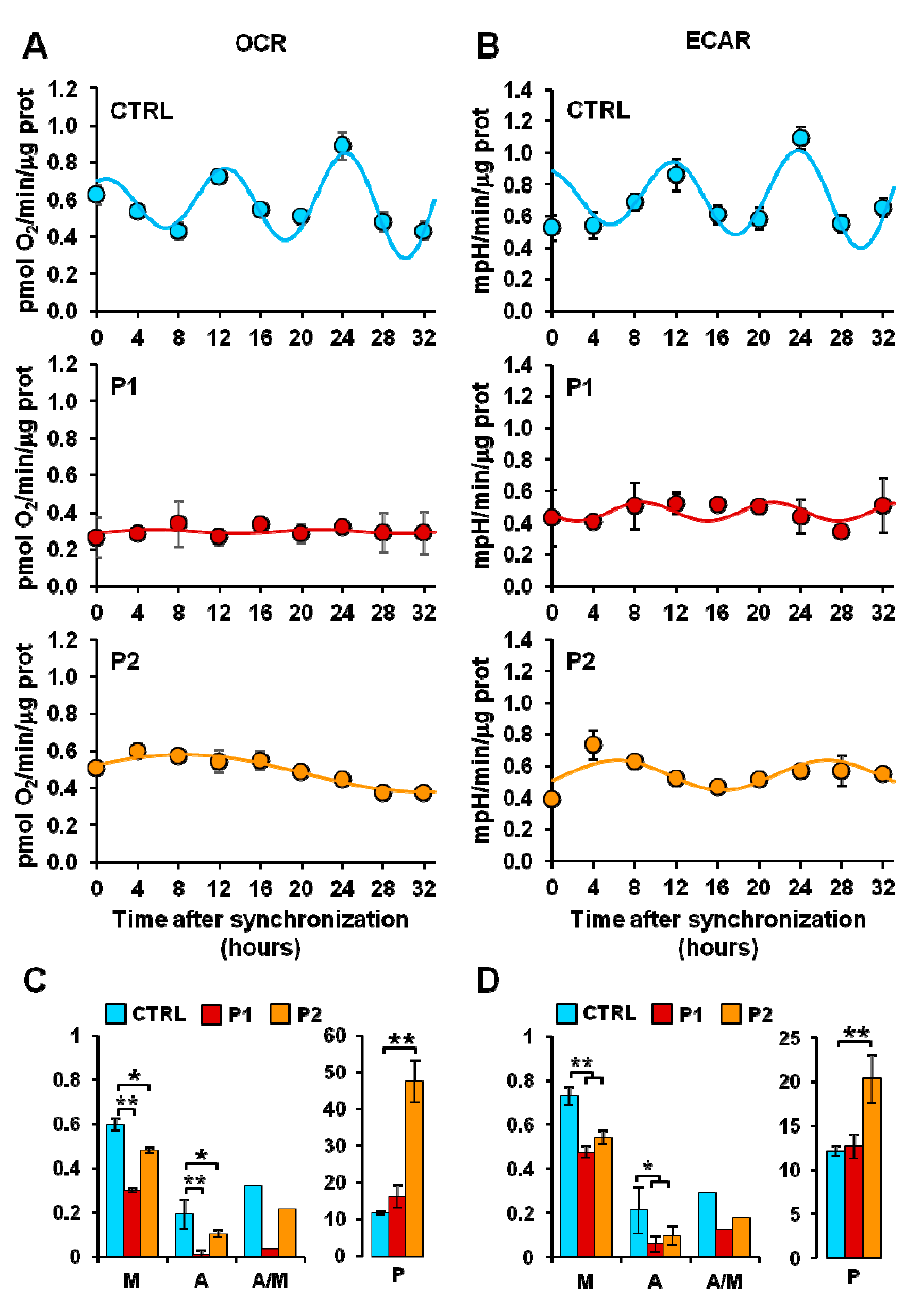
Figure 4. Measurement of the mitochondrial respiratory and glycolytic activity in serum shock-synchronized intact fibroblasts. ( A ) Resting oxygen consumption rate (OCR) and ( B ) basal extracellular acidification rate (ECAR) in serum shock-synchronized normal fibroblasts (CTRL) and PD patient-derived fibroblasts (P1, P2)—the time-course data points were best fitted with the COSINOR function. ( C , D ) The histograms display the mesor (M), the amplitude (A), and the A/M ratio for respiration ( C ) and glycolysis ( D ) of the best-fitting COSINOR. See Materials and Methods for details. Data are mean ± SEM of two independent experiments performed in triplicate. Statistical significance was calculated with Student’s t -test * p < 0.01, ** p < 0.005 vs.